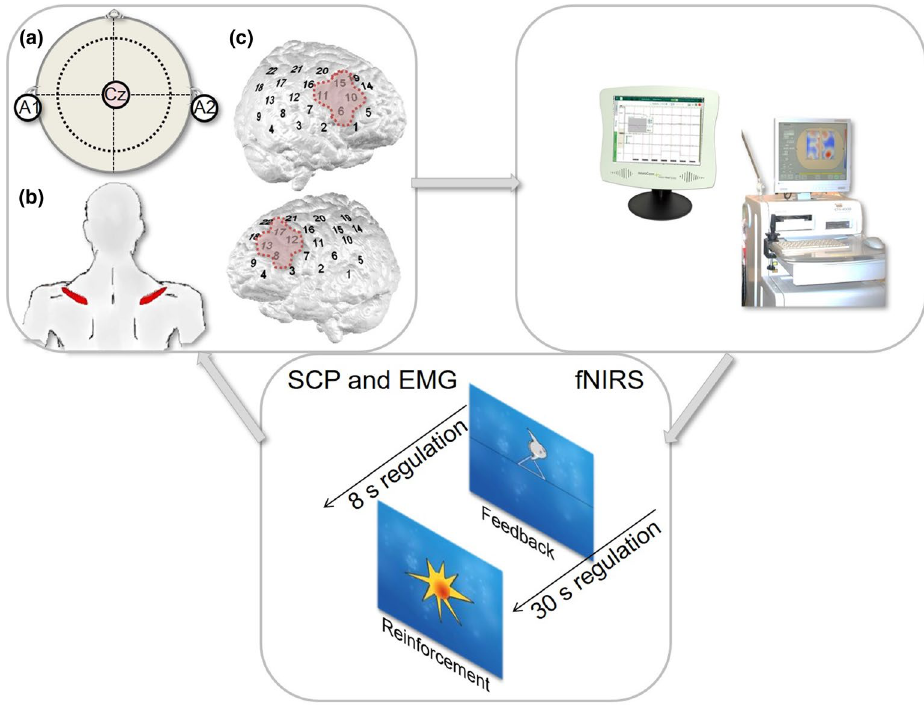
Figure 2. Experimental setup for ( a ) EEG-, ( b ) EMG- and ( c ) fNIRS